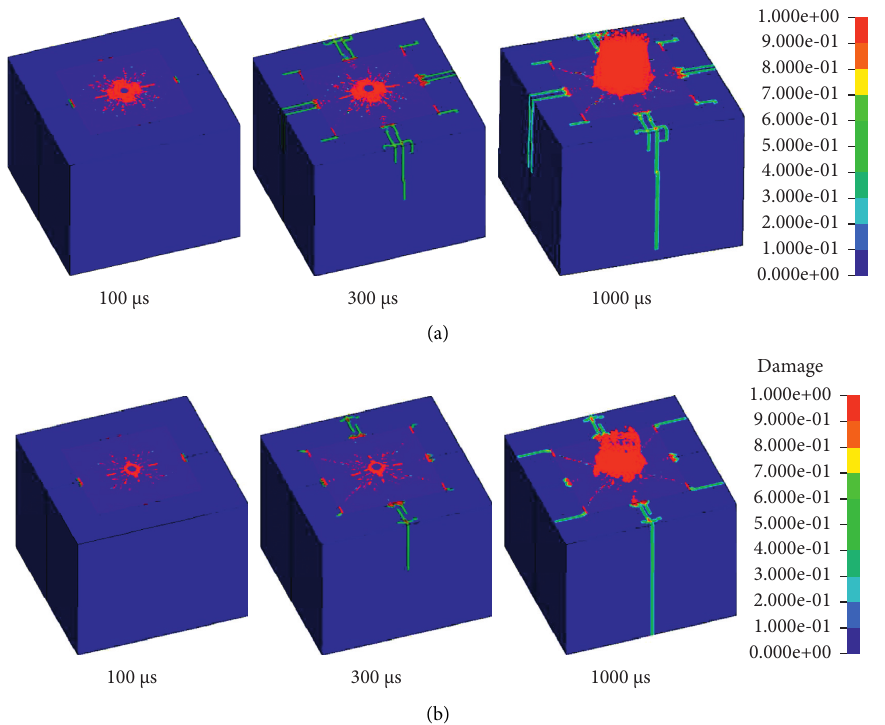
Figure 14: 3D damage map of the specimen model: (a) ordinary charge and (b) shaped charge.